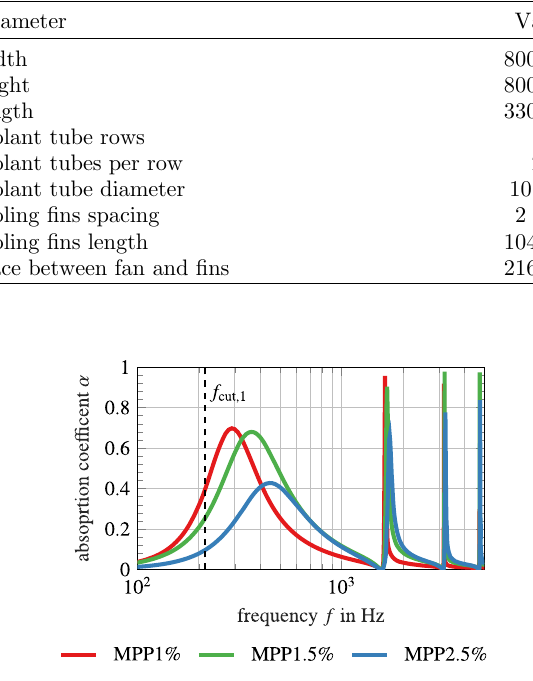
Figure 2. Estimated absorption coef fi cient from JCAL-model and cut-off frequency (dashed line).